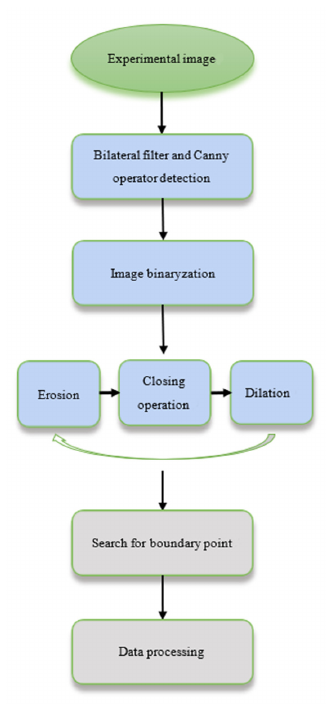
Figure 4. Flow chart of image processing program.